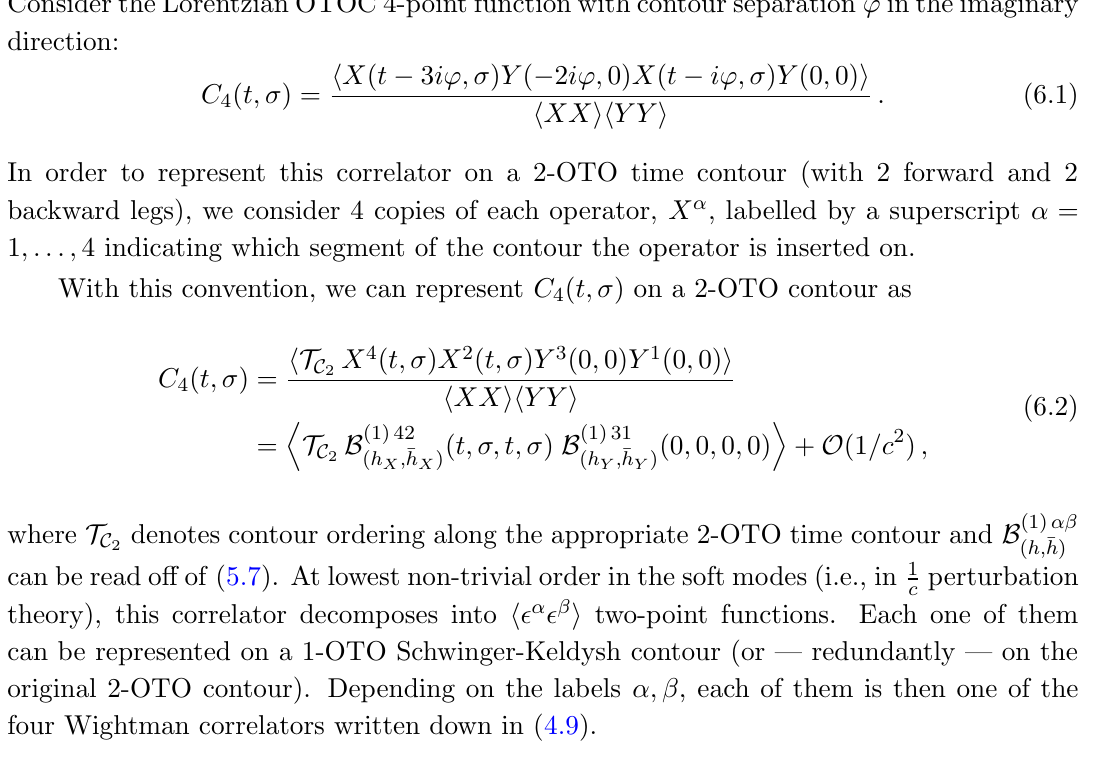
Analogously, B (2) (cid:11)(cid:12) also reads as in (5.4) with the replacements u ! i ( t + (cid:27) ) and (cid:22) u ! ( h; (cid:22) h ) i ( t (cid:0) (cid:27) ), and contour labels attached to the soft